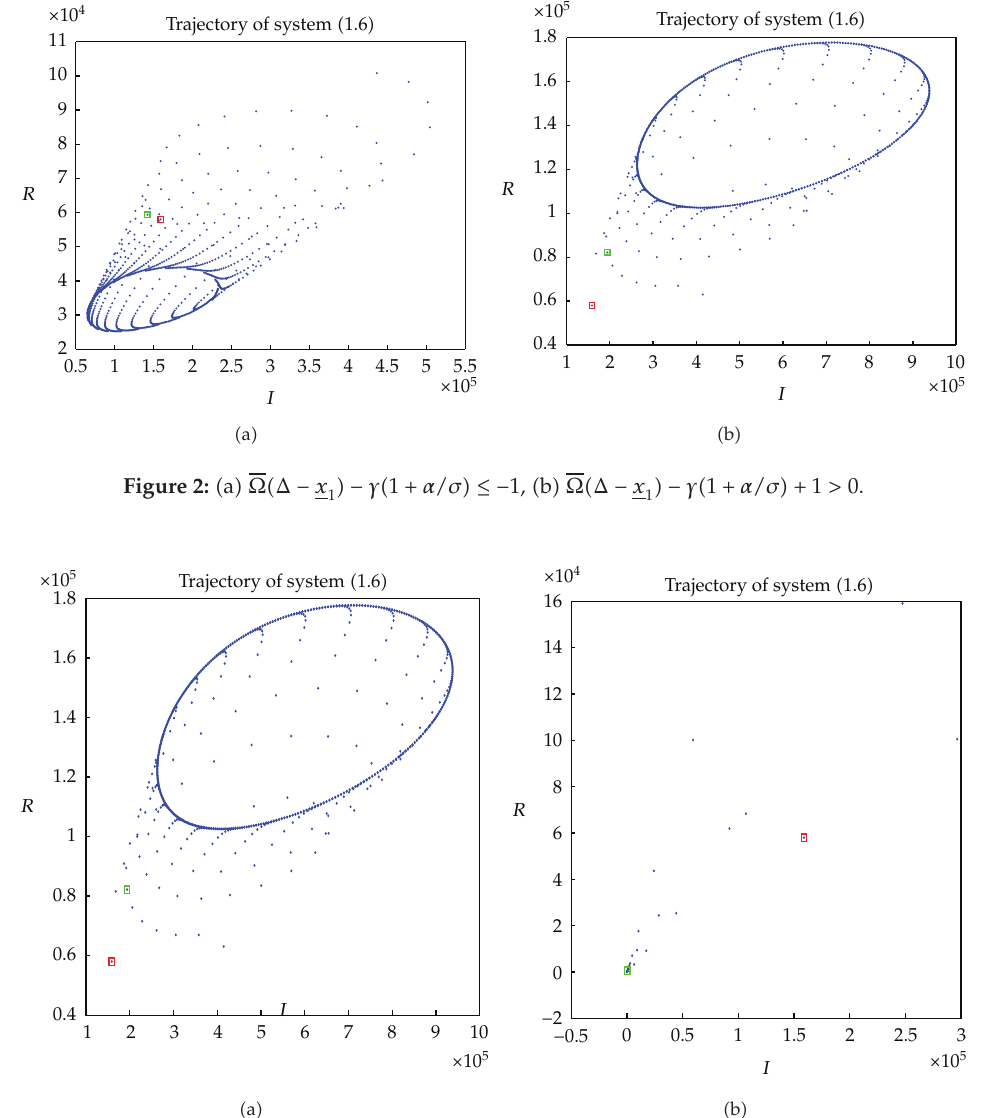
Figure 3: (cid:2) a (cid:5) (cid:2) 3 / 4 (cid:5) x 1 ≤ x 2 is not satisfied with r 3 (cid:6) 0 . 85; (cid:2) b (cid:5) (cid:2) 3 / 4 (cid:5) x 1 ≤ x 2 is satisfied with r 3 (cid:6) 2